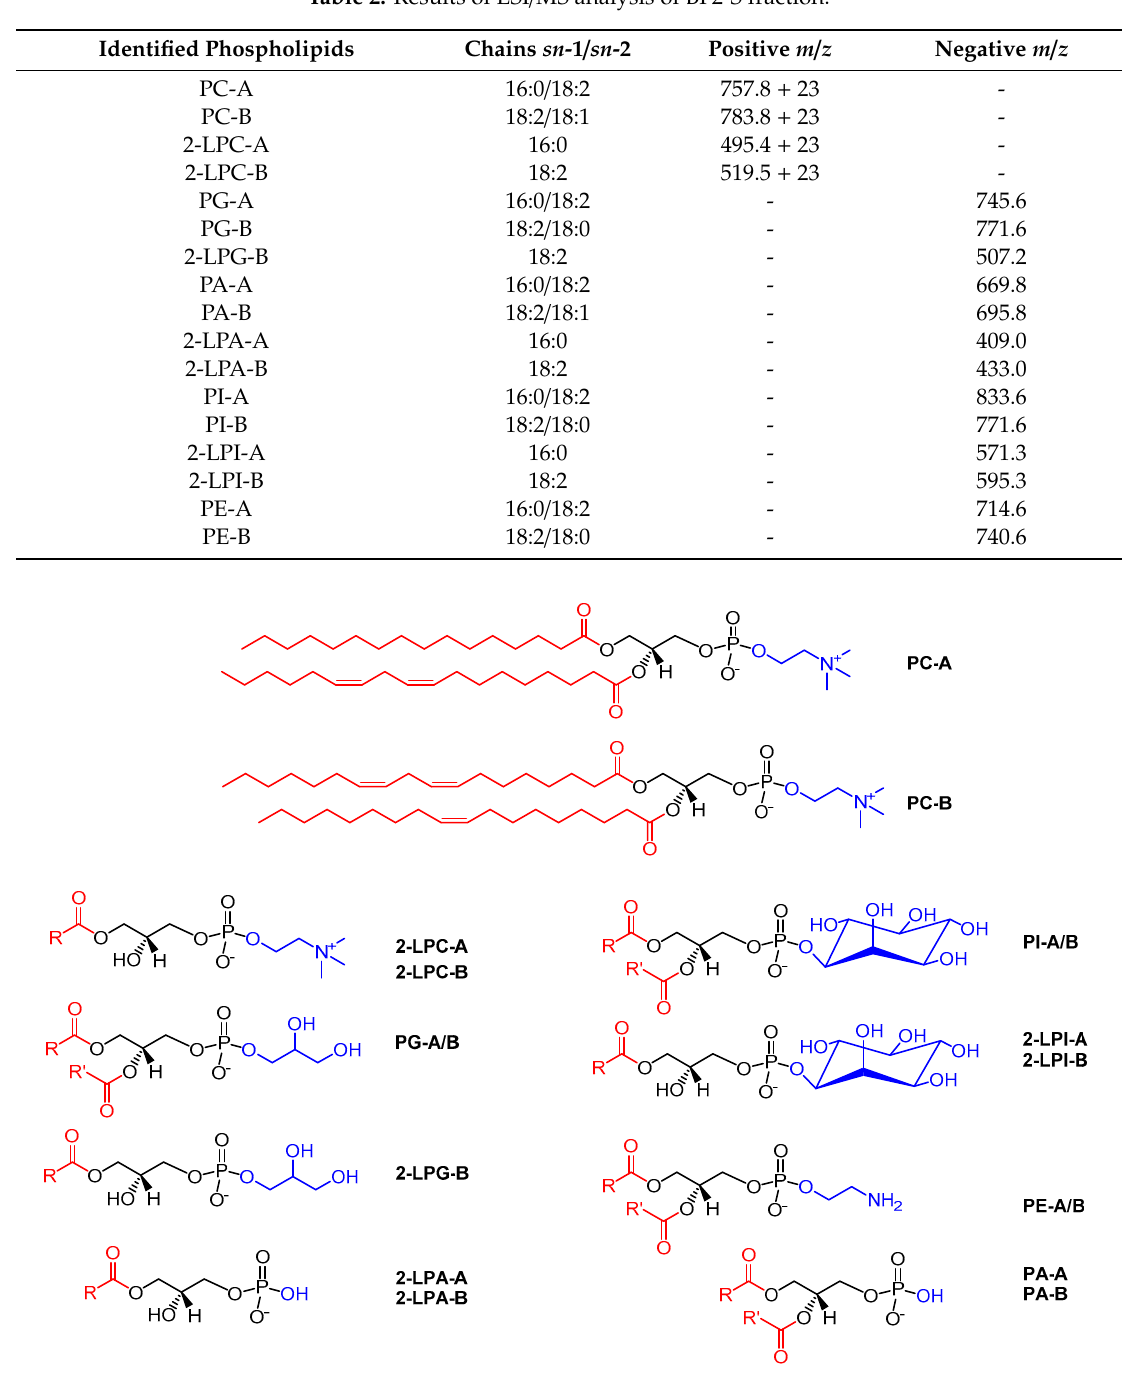
Table 2. Results of ESI/MS analysis of BF2-S